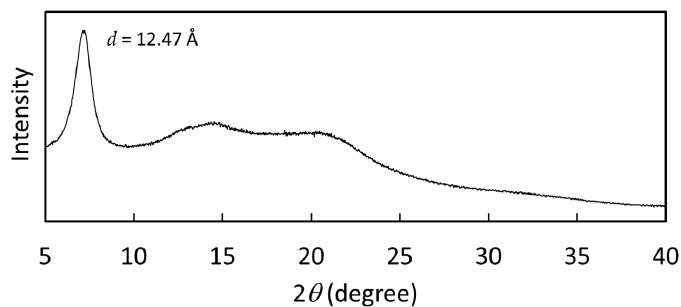
Figure 7. Powder X-ray diffraction of Fraction C [C 60 ( n C 3 H 7 ) 20